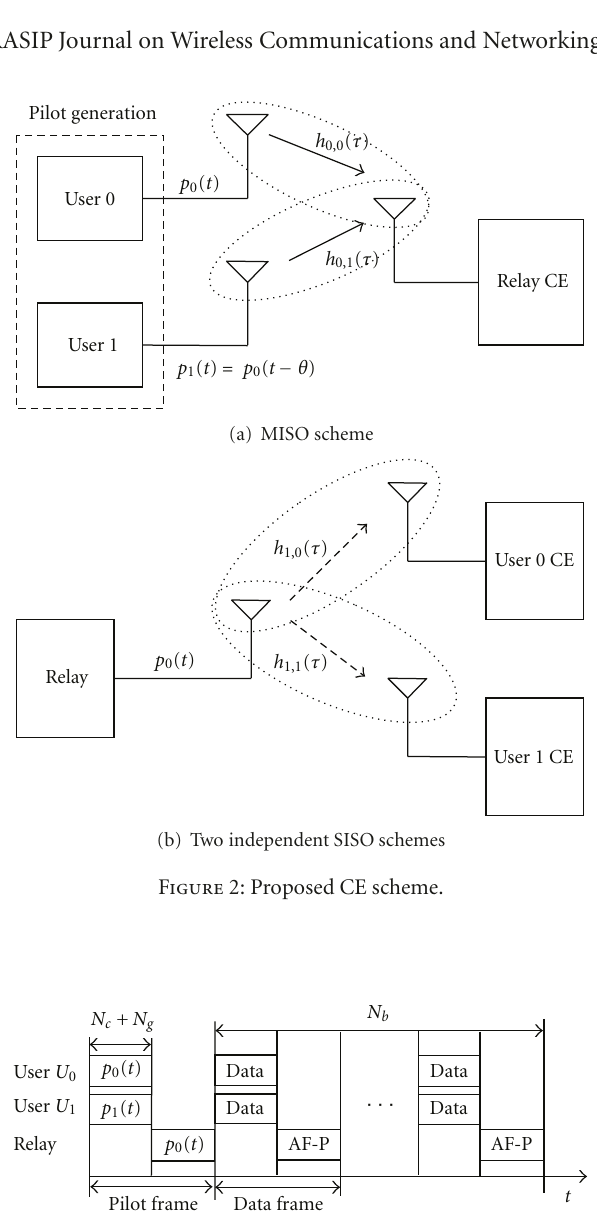
Figure 3: Pilot and data transmission